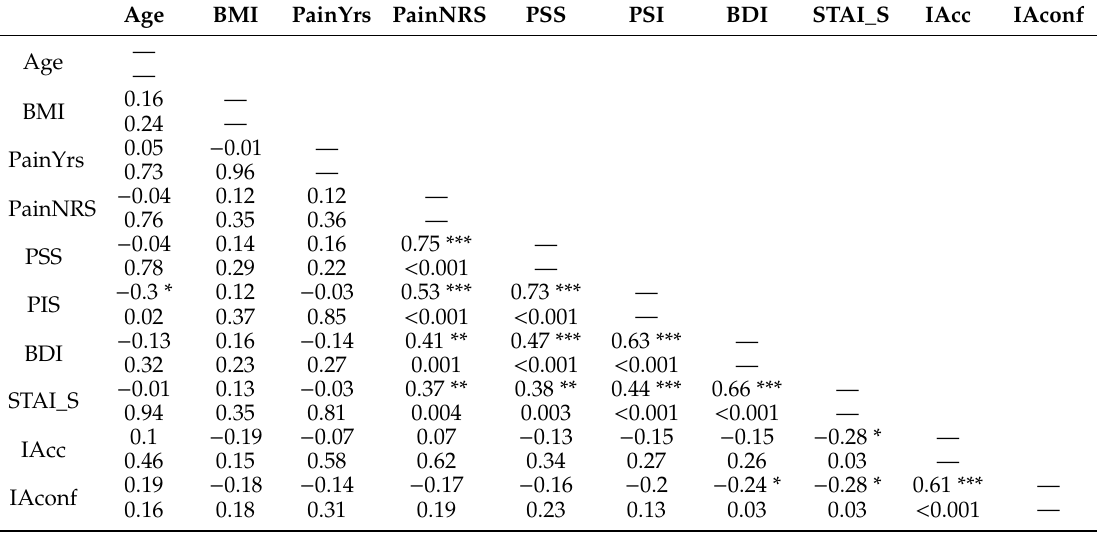
Table 3. Pearson Correlation Matrix for principal variables in the CP patients ( N =